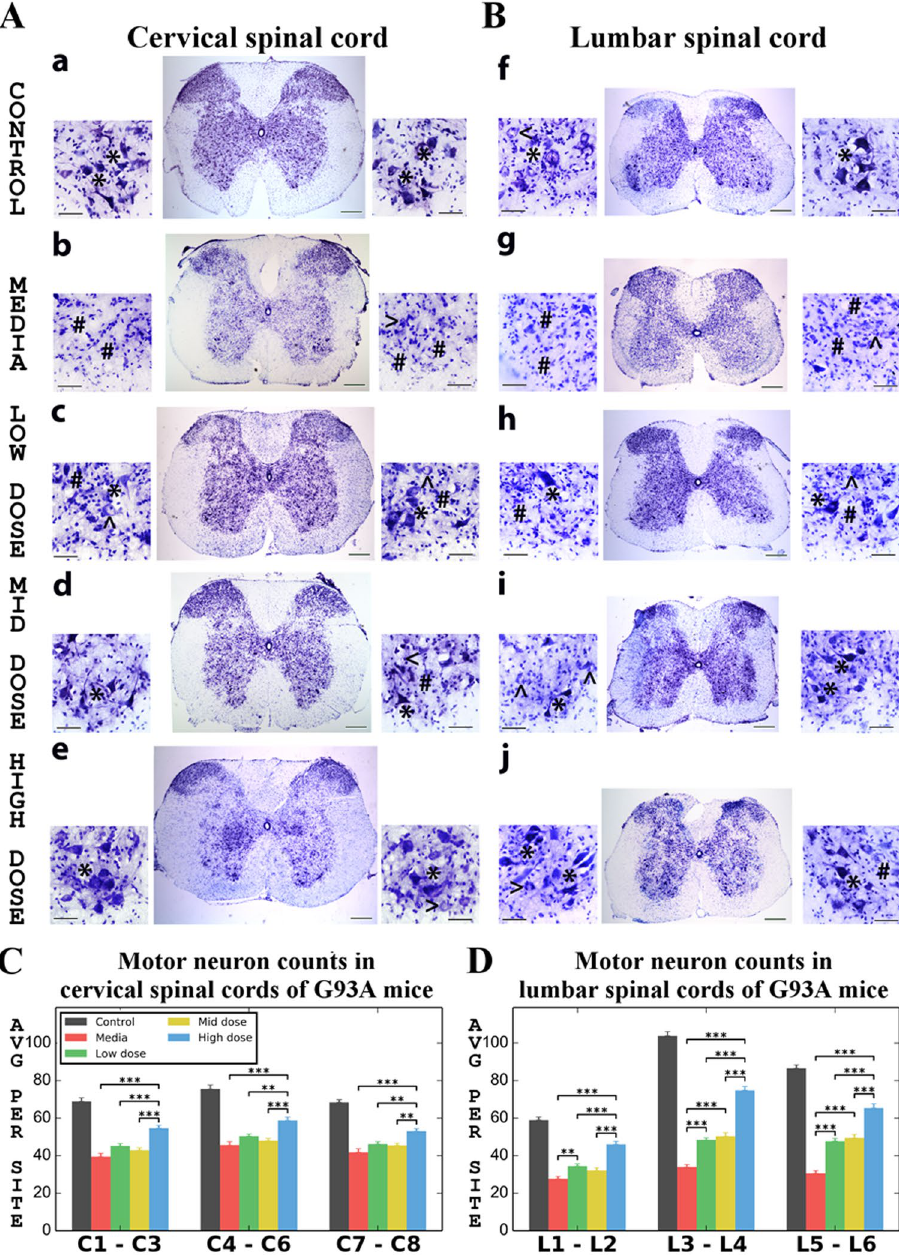
Figure 8. Characteristics of motor neurons in the cervical and lumbar spinal cord of G93A. Histological analysis of motor neurons in ( A ) cervical (C3) and ( B ) lumbar (L3) spinal cords (cresyl violet staining) showed healthy motor neurons in control animals (a,f, asterisks). Most motor neurons had degenerated or vacuolated in the cervical (b) and lumbar (g) spinal cords of media-injected mice at 17 wks of age. Mice receiving low or mid cell dose demonstrated more healthy-appearing motor neurons (asterisks) in both segments of the spinal cord (low dose – c,h; mid dose – d,i); yet some degenerated motor neurons were noted in addition to vacuolated cells. Higher motor neuron survival in the cervical (e) and lumbar (j) spinal cords was determined in mice treated with high cell dose. Only a few motor neurons were vacuolated. * - healthy motor neuron, # - degenerated motor neuron, < - vacuolated motor neuron. Scale bar in a-j for full coronal spinal cord section is 200 µ m and in ventral horn insert is 50 µ m. ( C ) Stereological motor neuron counts in discrete levels of the cervical spinal cord showed significantly decreased motor neuron survival in media-injected mice vs. controls. Only ALS mice receiving the high cell dose demonstrated significantly greater motor neuron numbers in all analyzed spinal cord levels compare to other cell-treated or media-injected mice. ( B ) In the lumbar spinal cord, significantly lower motor neuron numbers at all discrete cord levels were found in media-injected mice vs. controls, similar to results in the cervical spinal cord. Stereological counts of motor neurons in mice treated with different cell doses showed significantly increased cell numbers in the ventral horns compared to media-injected animals. Best motor neuron survival was determined in mice treated with high cell dose. ** p < 0.01, *** p <